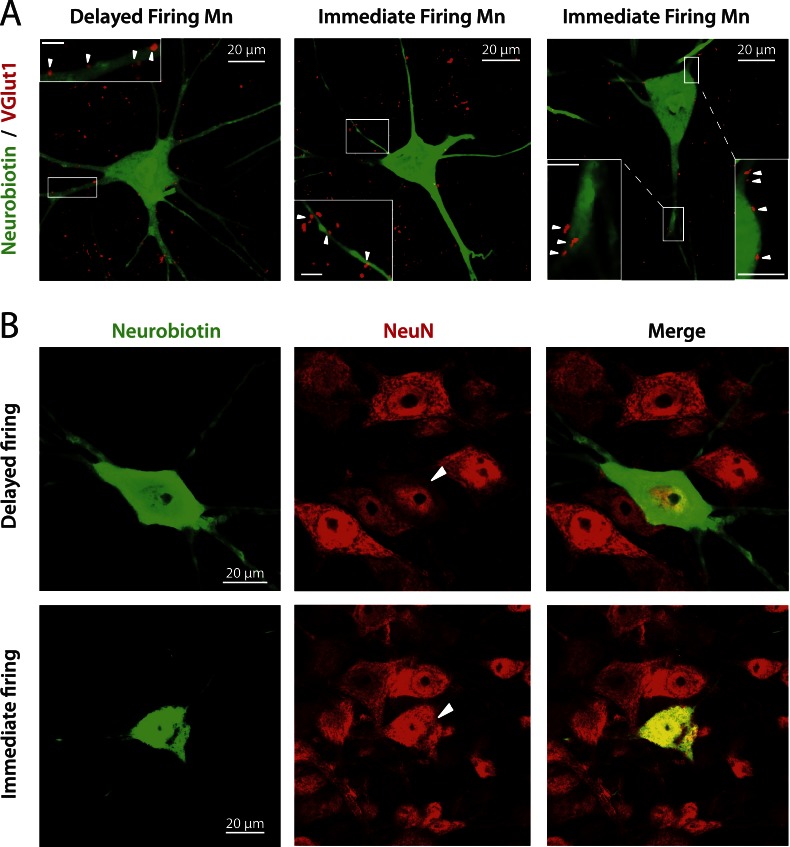
immediate and delayed firing motoneurons both receive VGlut1 inputs and express NeuN.(A) Vglut1 (red) synaptic inputs are apposed to neurobiotin (green) filled motoneurons (examples of appositions pointed by arrowheads in the inserts that show enlargements of the areas surrounded by rectangles). The bar scale in all insets is 5 μm. (B) NeuN staining (red) of neurobiotin (green) filled motoneurons. The arrowheads point to the cell bodies of the motoneurons that have been intracellularly filled during the electrophysiological experiment.